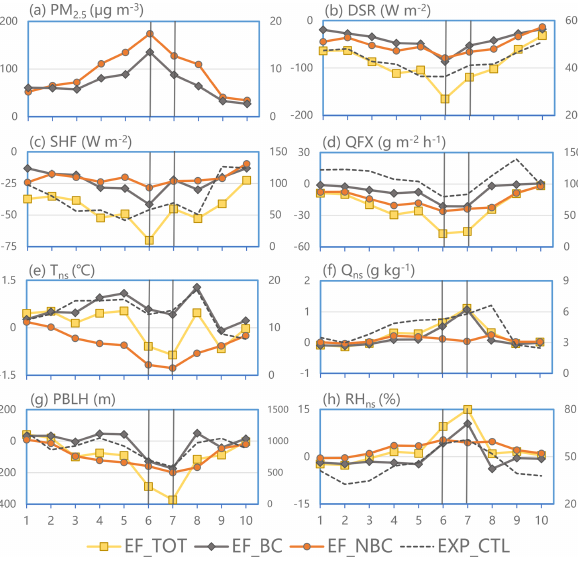
Figure 7. The contributions of EF_TOT, EF_BC and EF_NBC to the change of near-surface layer properties (the magnitude is de- noted by the left axis) at 14:00LST each day during 1–10 Decem- ber 2013, and the results from EXP_CTL (the magnitude is denoted by the right axis) are plotted as references. The data are calculated from the simulated results at the lowest grid level over the YRD